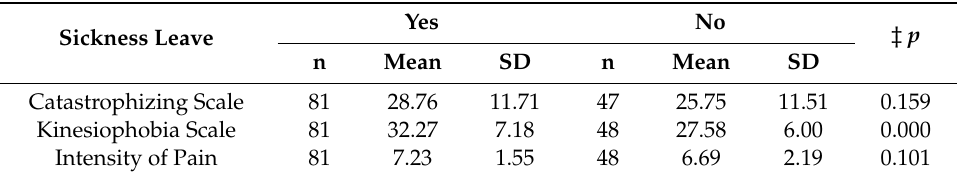
Table 2. Mean values for the di ff erent clinical variables as a function of the presence (yes) or absence (no) of sickness leave status. ‡